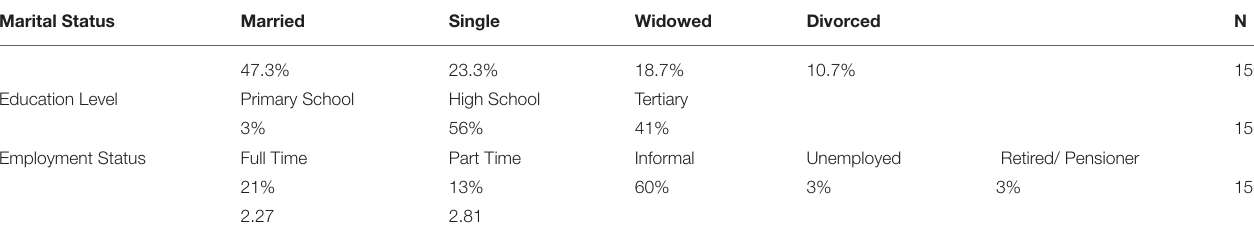
TABLE 1 | Marital status, level of education and employment status of women in home-based informal businesses.